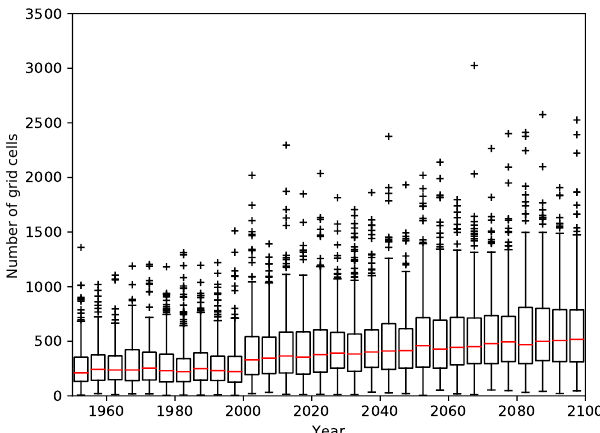
Figure 3. Number of BCSD grid cells in the CONUS experiencing their maximum daily precipitation in each year between 1950 and 2100 per model. The box and whisker plots represent spread across all of the individual models used in the flow simulations. The step in the year 2000 is an artifact of the BCSD method ( p value < 0.001). The baseline 1% AEP event was calculated using the years